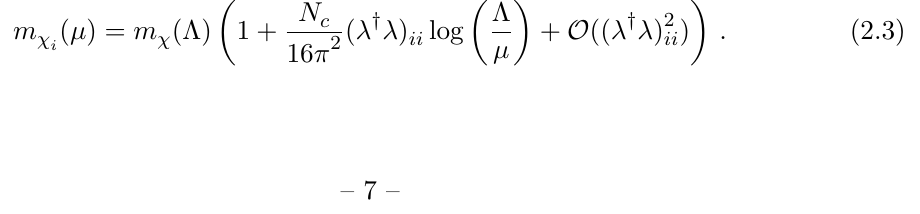
Figure 2 . Illustration of relic density over time ( x = m RD bounds with mass splitting calculated with the e(cid:11)ective method mentioned in the main text (hatched regions for which the DMFV models allows the correct relic abundance)